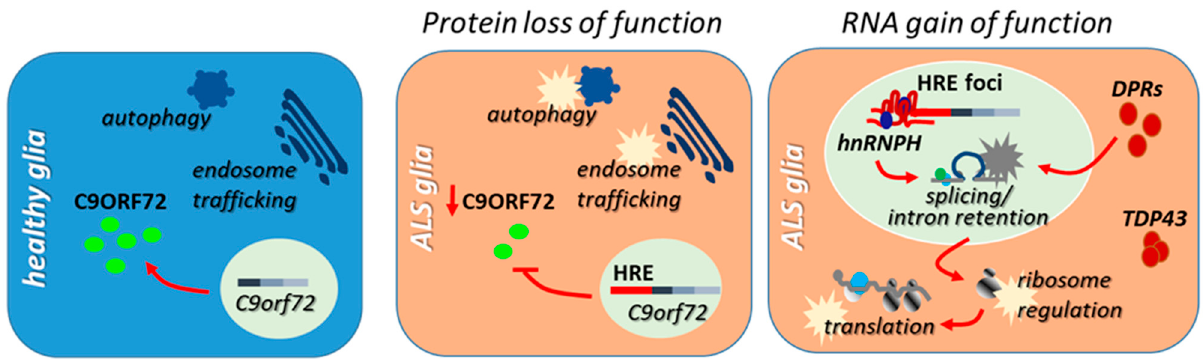
Figure 3. Contribution of loss- and gain-of-function mechanisms to the inflammatory processes mediated by C9orf72-ALS astrocytes and microglia. In ALS astrocytes and microglia, the loss of C9ORF72 protein induced by the presence of expanded hexanucleotide repeats (HRE) in the first intron of the C9orf72 gene, impacts the regulation of autophagy and endosome trafficking, and is linked to the upregulation of proinflammatory cytokines, altered immune responses, and